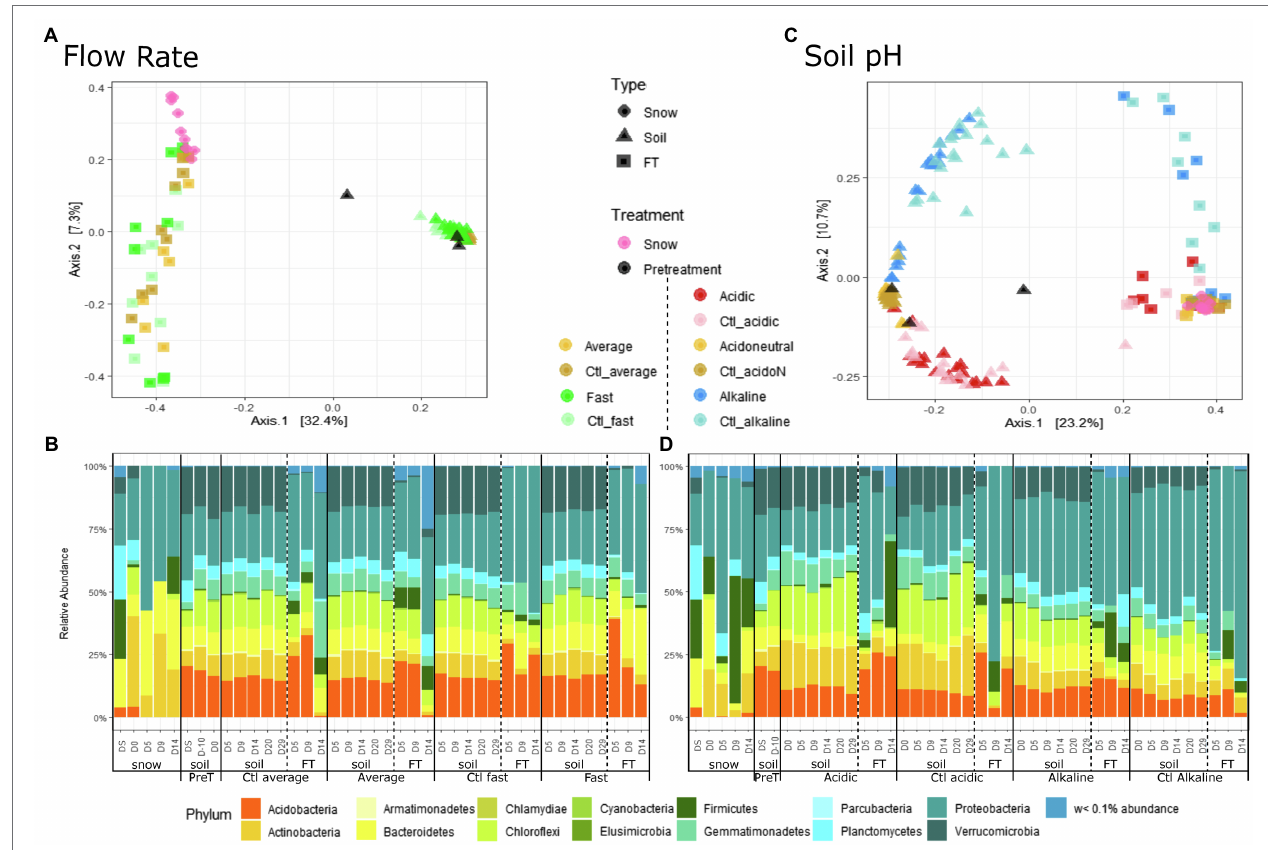
FIGURE 3 | Principal coordinate analysis (PCoA) and community composition at the phylum level, by experiment, treatment, sample type and day of sampling. (A) PCoA and (B) community composition of flow rate microcosms. (C) PCoA and (D) community composition of soil pH microcosms. Pretreatment (PreT) includes the day of field sampling (DS), the day of microcosm set-up (D-10) and D0 for the flow rate experiment as the soil was not yet treated in any way. ‘w<0.1% abundance’ regroups all phyla with less than 0.1% relative